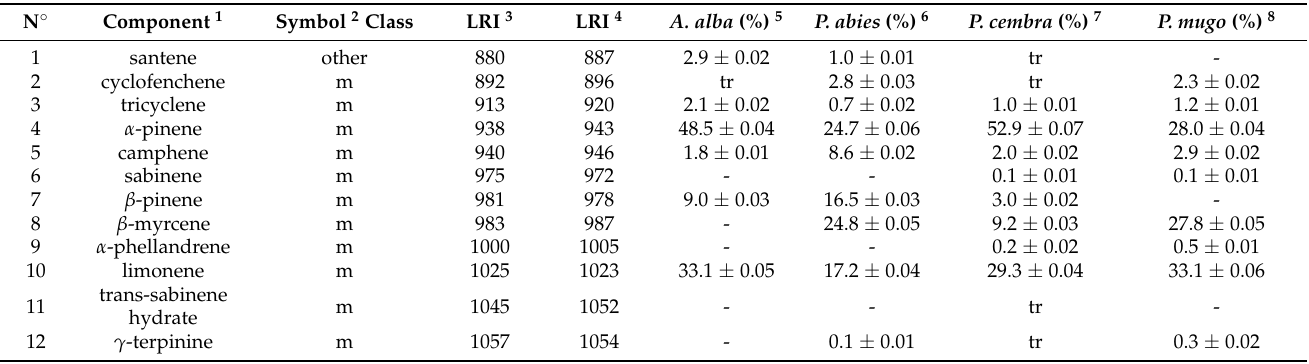
Table 1. Vapor phase chemical composition (%) of A. alba, P. abies , P. cembra and P. mugo EOs, as determined by